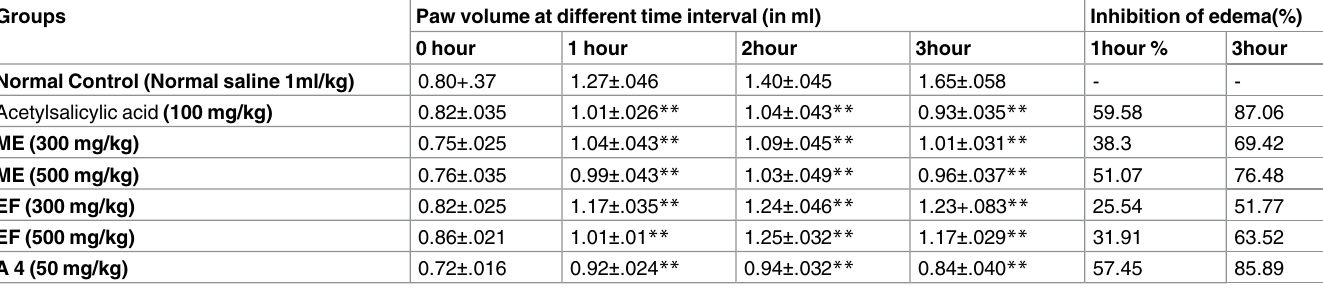
Table 1. Effect of M . philippensis on Carrageenan induced paw edema.